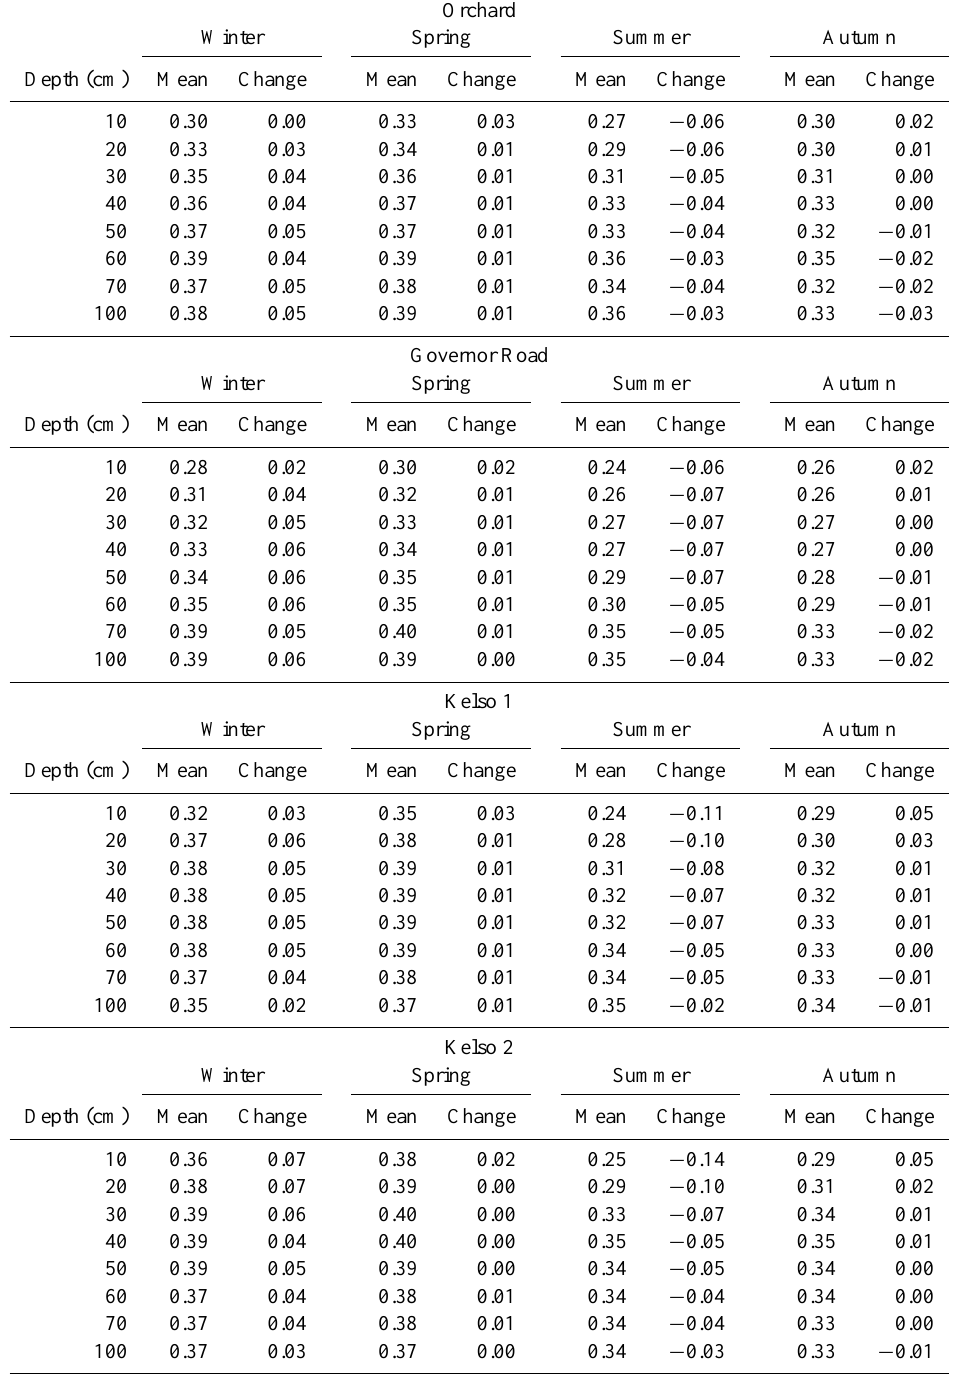
Table 3. Mean soil moisture for Winter (December, January, February), Spring (March, April, May), Summer (June, July, August) and Fall (September, October, November), and the average change between seasons at each site and